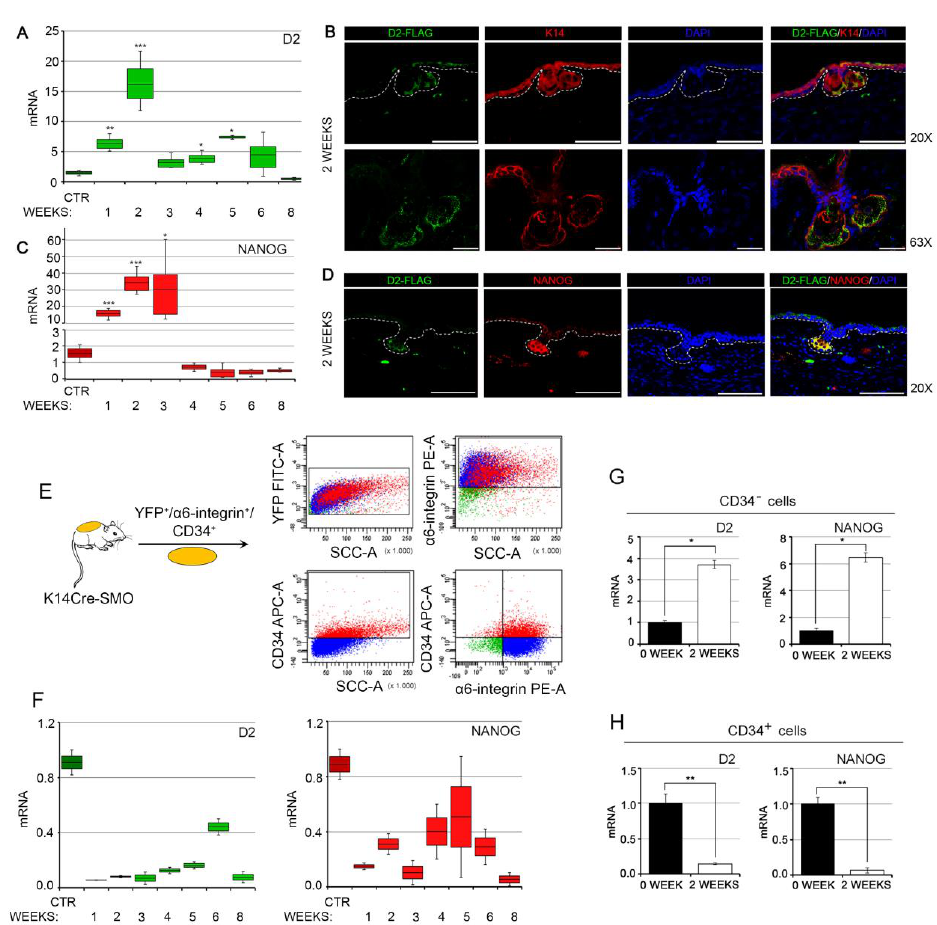
Figure 3. D2 expression correlates with NANOG expression during BCC tumor formation. ( A ) D2 expression was assessed by real-time PCR at di ff erent stages of BCC tumorigenesis in the adult epidermis of K14Cre-SMO mice. ( B ) D2 localization was assessed by immunofluorescence analysis two weeks after the induction of BCC tumorigenesis in the adult epidermis of K14Cre-SMO mice. Magnification 20 × and 63 × ; scale bars represent 100 µ m and 25 µ m, respectively. ( C ) Relative expression of NANOG mRNA at di ff erent stages of BCC tumorigenesis, as in A. ( D ) Representative D2 / NANOG co-staining was performed on para ffi n-embedded skin sections at two weeks of BCC tumorigenesis from the ear epidermis of K14Cre-SMO mice. Magnification 20 × ; scale bars represent 100 µ m. Data represent the mean of four independent experiments performed in triplicate. ( E ) Schematic representation of the strategy used to isolate cancer stem cell (CSCs) from K14Cre-SMO. ( F ) Transcriptional profile of D2 and NANOG in the CSCs population (CD34 + cells) during BCC tumorigenesis. ( G ) D2 and NANOG mRNA expression levels in FACS-isolated CSCs (CD34 + cells) were measured by real-time PCR. ( H ) D2 and NANOG mRNA expression levels in the FACS-isolated non-CSC population (CD34 − cells) were measured by real-time PCR. Data represent the mean of four independent experiments performed in triplicate; * p < 0.05, ** p < 0.01, *** p < 0.001.